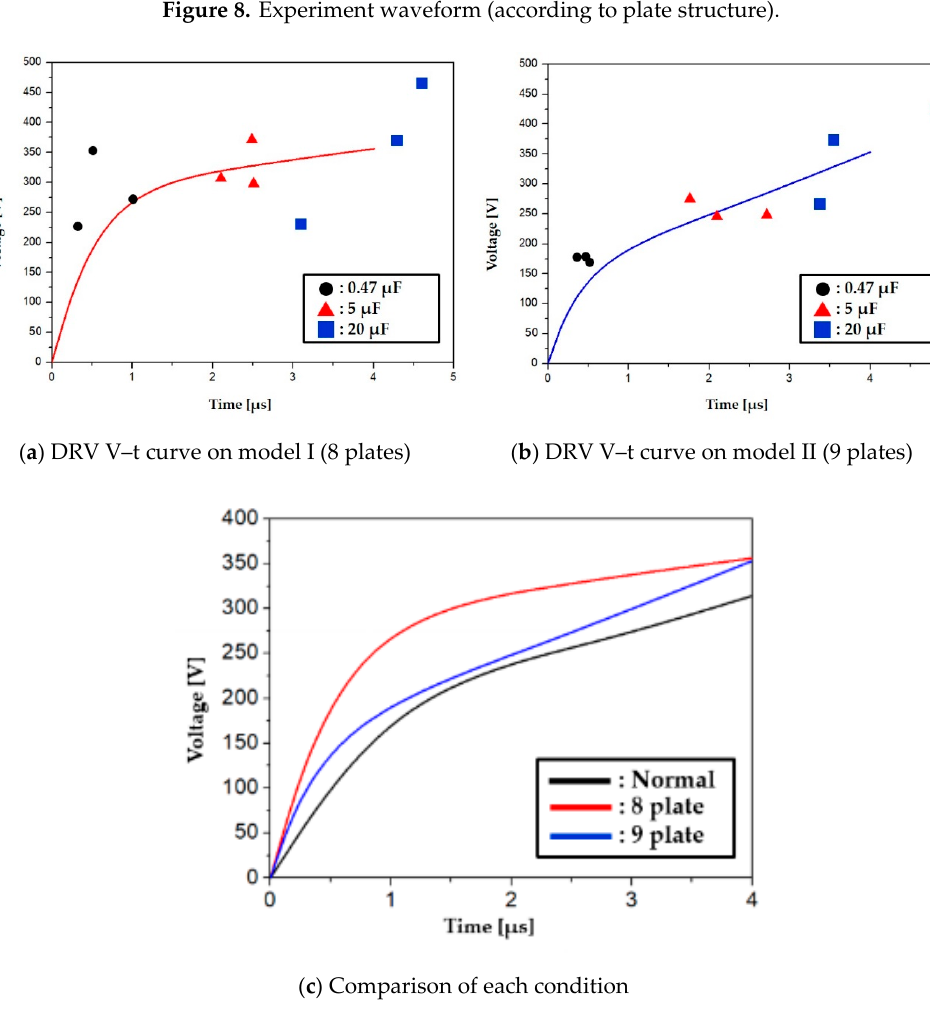
Figure 9. Dielectric recovery voltage V–t curve (according to plate